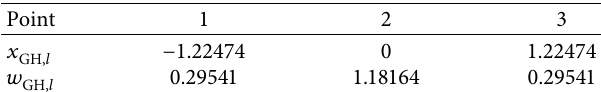
Table 1: Abscissas and weights for Gaussian–Hermite integration with r � 3 [39].